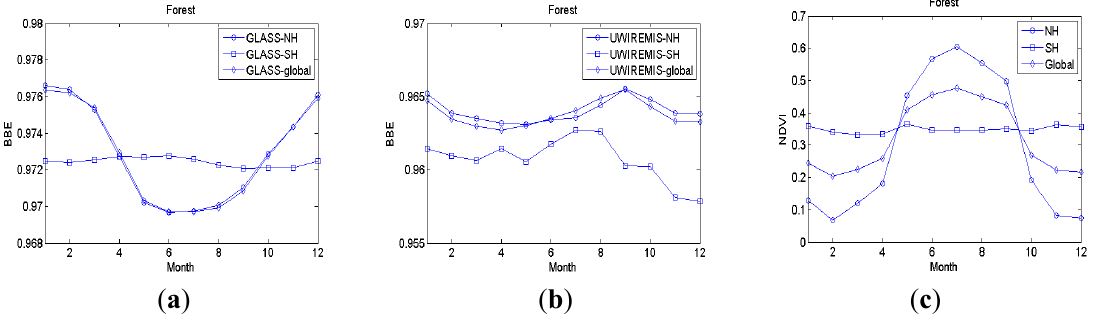
Figure 8. Monthly mean BBE of five land cover types calculated from UWIREMIS BBE and GLASS BBE for global, North Hemisphere (NH) and South Hemisphere (SH), respectively. ( a ) GLASS Forest BBE; ( b ) UWIREMIS Forest BBE; ( c ) MODIS Forest NDVI; ( d ) GLASS Grass BBE; ( e ) UWIREMIS Grass BBE; ( f ) MODIS Grass NDVI; ( g ) GLASS Crop BBE; ( h ) UWIREMIS Crop BBE; ( i ) MODIS Crop NDVI; ( j ) GLASS Shrub BBE; ( k ) UWIREMIS Shrub BBE; ( l ) MODIS Shrub NDVI; ( m ) GLASS Savanna BBE; ( n ) UWIREMIS Savanna BBE; ( o ) MODIS Savanna